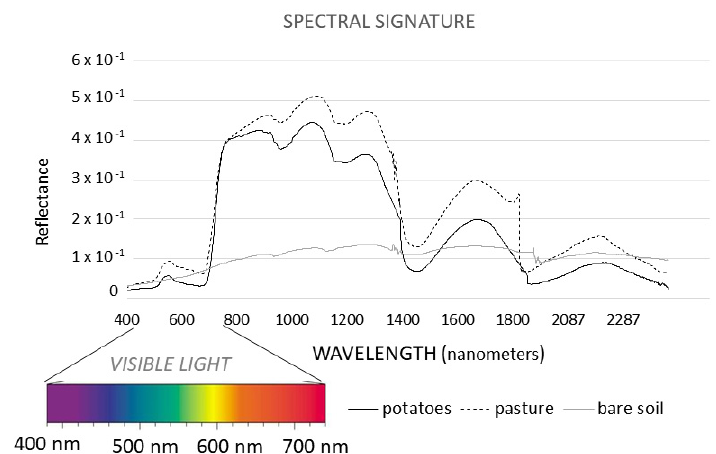
Figure 4. Reflectance according to the spectral region and wavelengths calculated on the study plots by means of a ASD FieldSpec 4 Hi ‐ Res NG Spectroradiometer, Malvern Panalytical Ltd, Cambridge, United Kingdom (n = 50 per land use: potatoes, bare soil and pasture). Source: Current research